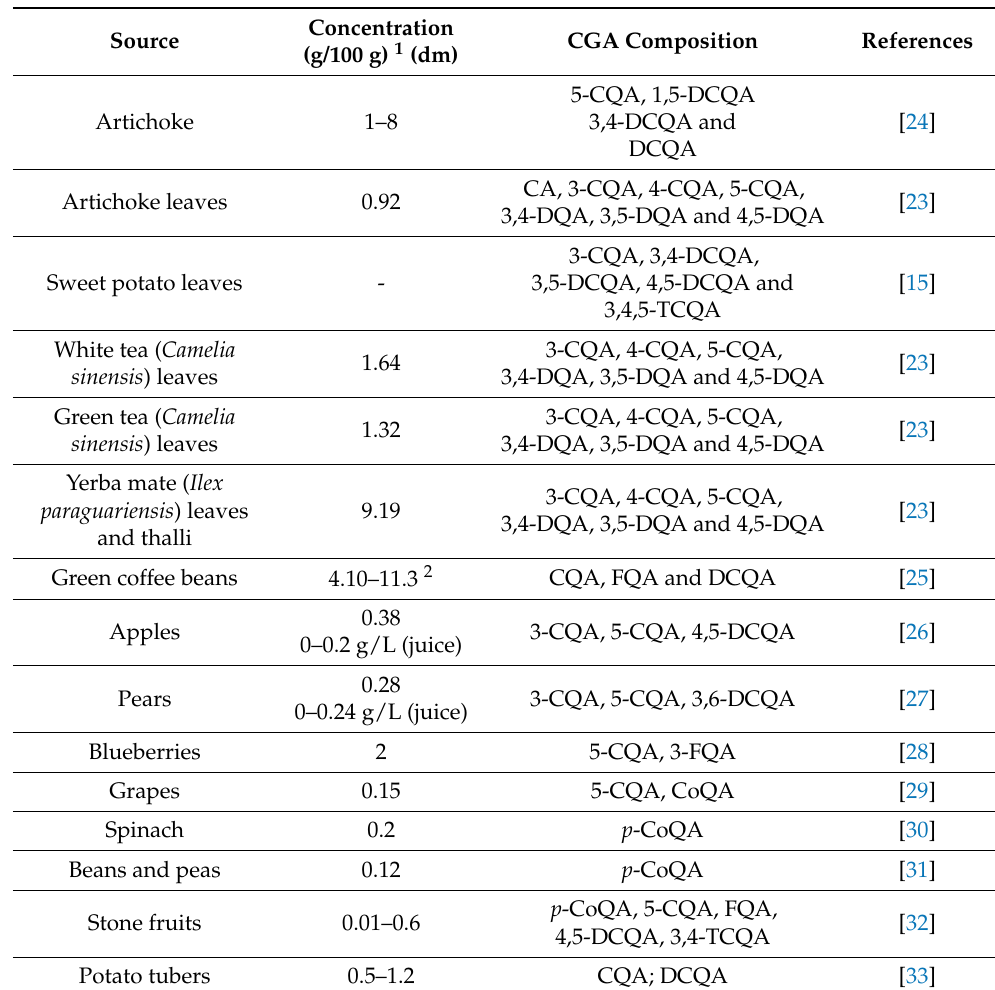
Table 1. Main sources of